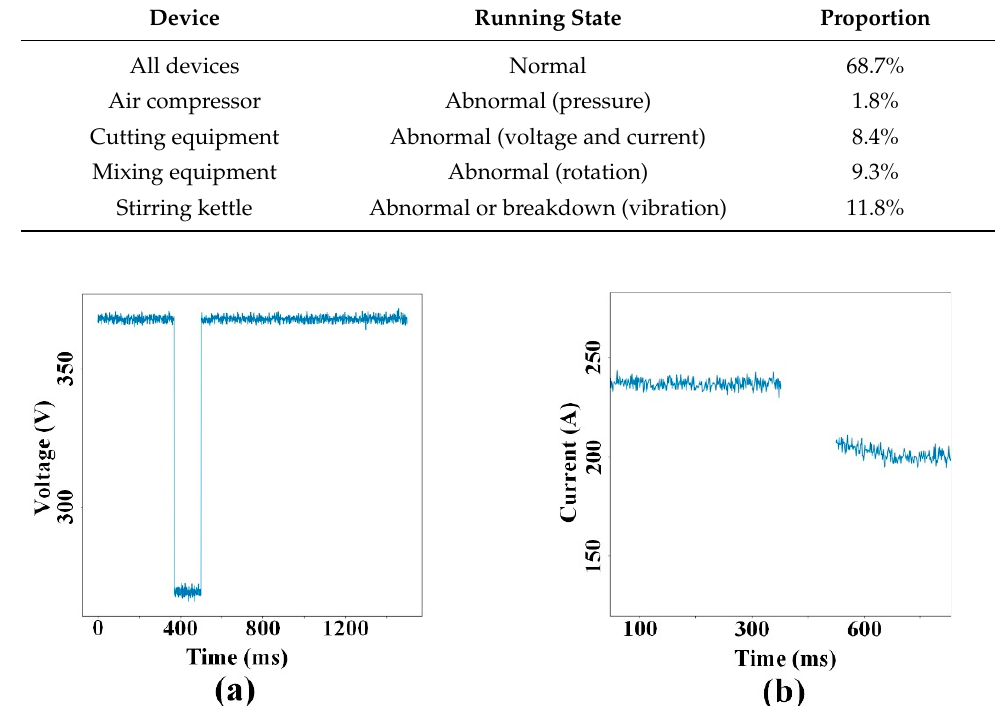
Figure 6. Original data captured from various sensors. Subplots ( a , b ) are curves of voltage and current, in which abnormal data exist.